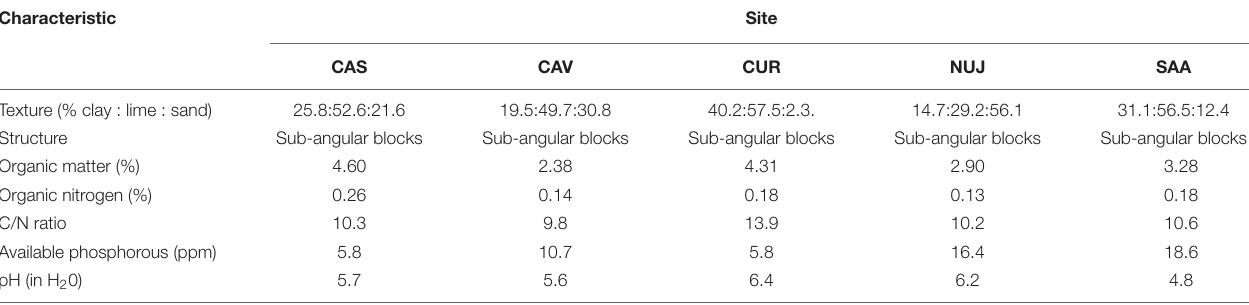
TABLE 1 | Main characteristics of the soils from where the soybean-nodulating isolates were obtained. Characteristic Site CAS CAV CUR NUJ